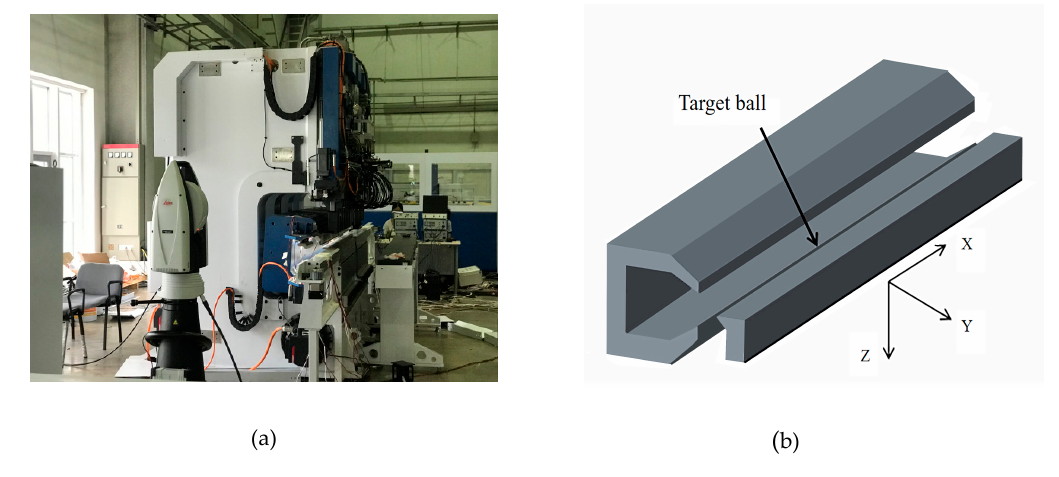
Figure 10. Testing situation: ( a ) Test on site. ( b ) Target ball